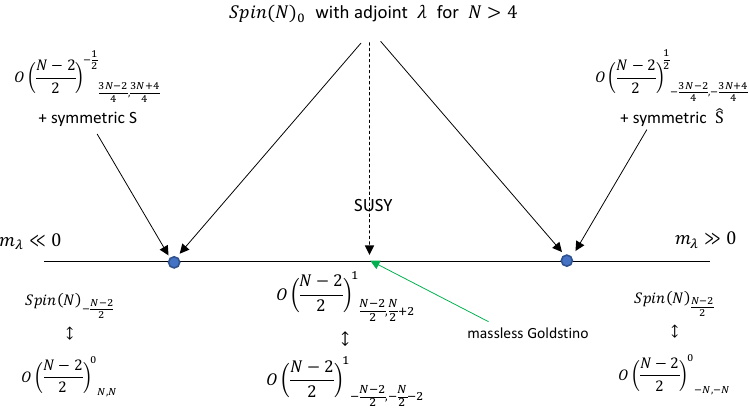
Figure 5: The phase diagram of a Spin ( N ) gauge theory coupled to a fermion λ in the adjoint representation. The phase transitions are visible at weak coupling in a dual theory with symmetric tensor fermions. This can be derived from the SO ( N ) gauge theory by gauging the UV magnetic symmetry M UV , which corresponds to gauging the symmetry C IR M IR in the long-distance TQFT [ 15 ]